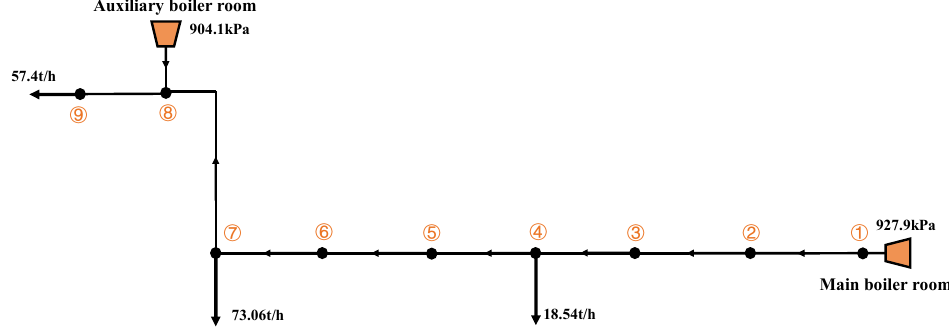
Figure 10. Nine-node double-heat-source tree steam heating network.